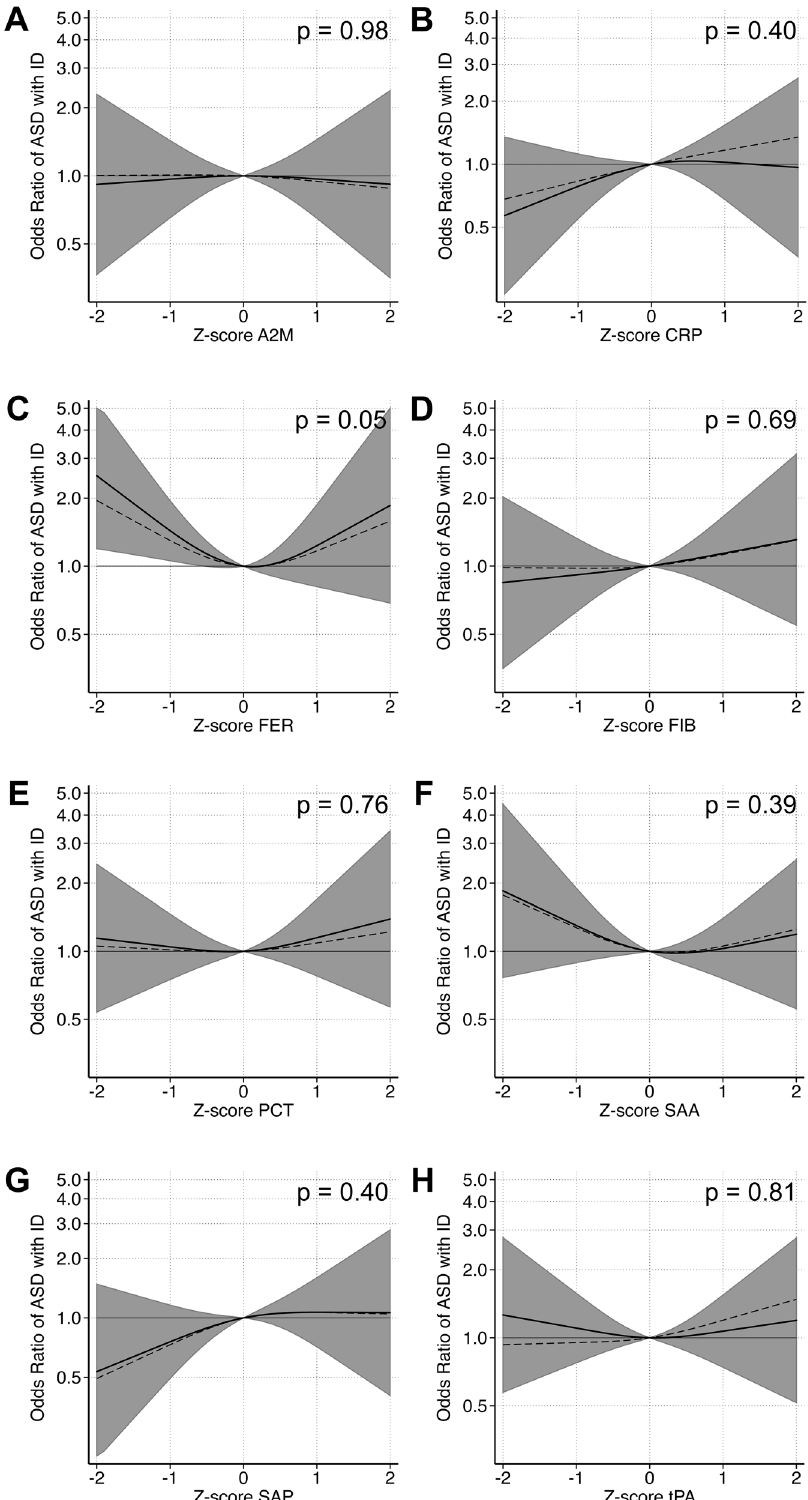
Fig. 3 The relationship between maternal APP measured prenatally and odds of ASD with ID when comparing mothers of 101 individuals affected by ASD with ID to mothers of 429 unaffected individuals selected from the cohort. Each panel displays the odds of ASD with ID according to APP z-score, fl exibly fi t using restricted cubic spline models with three knots and a z-score = 0 as the referent. The dashed line represents the unadjusted estimate of the relationship between each APP and odds of ASD with ID. The solid line represents the fully adjusted model, adjusted for sex, birth order, maternal BMI, maternal psychiatric history, maternal region of origin, maternal age and family income quintile. The gray bands represent the 95% con fi dence interval for the fully adjusted model. P values are shown for a Wald test with a null hypothesis that all APP spline terms were jointly equal to zero, as a test of whether each APP was generally associated with the outcome. Abbreviations: A2M α -2 macroglobulin, CRP C-reactive protein, FER ferritin, FIB fi brinogen, PCT procalcitonin, SAA serum amyloid A, SAP serum amyloid P, tPA tissue plasminogen